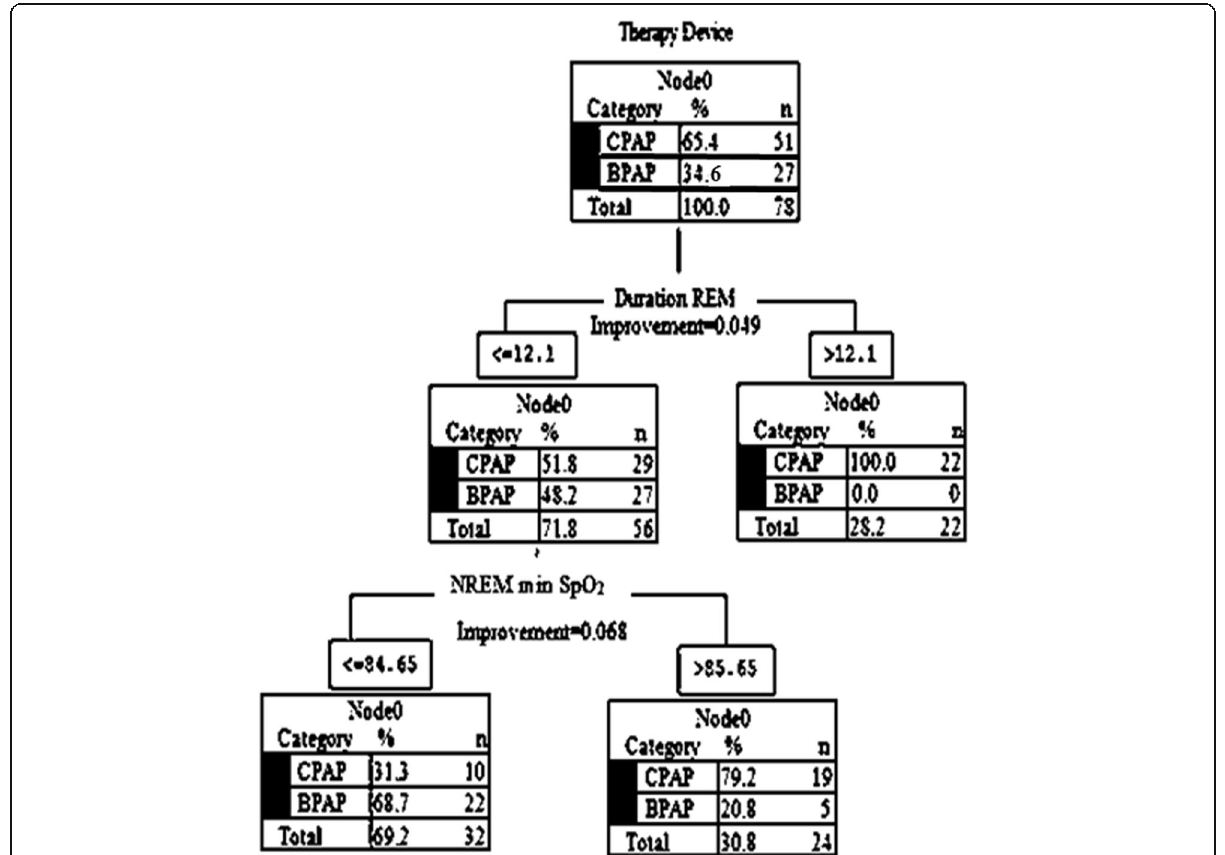
Fig. 2 Decision tree analysis of OSA individuals undergoing PAP titration defining variables effective on change from CPAP to BiPAP